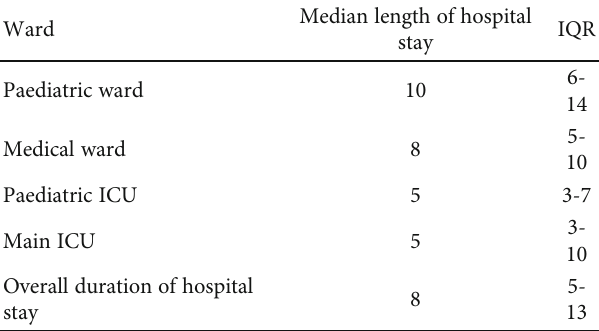
Table 5: Duration of hospital